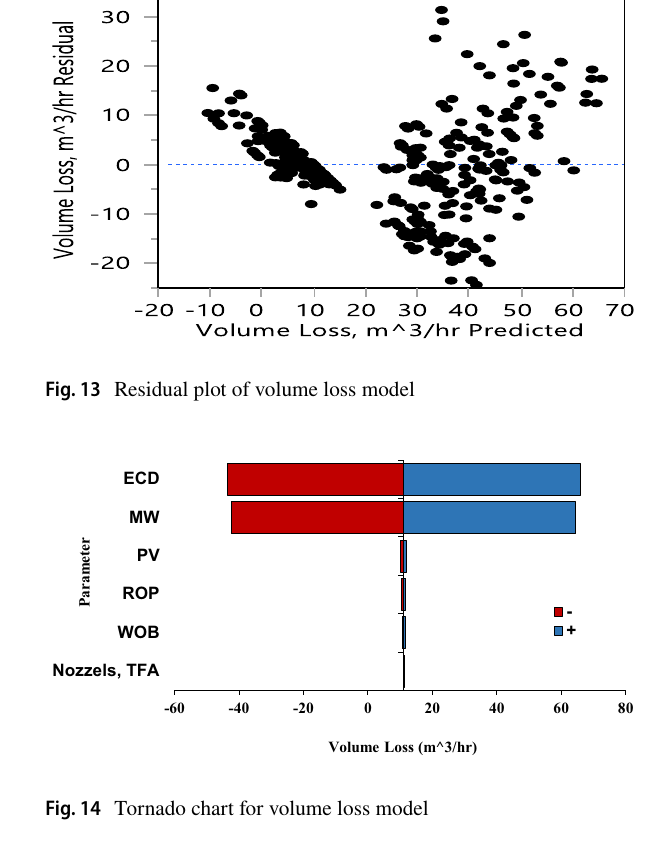
Fig. 14 Tornado chart for volume loss